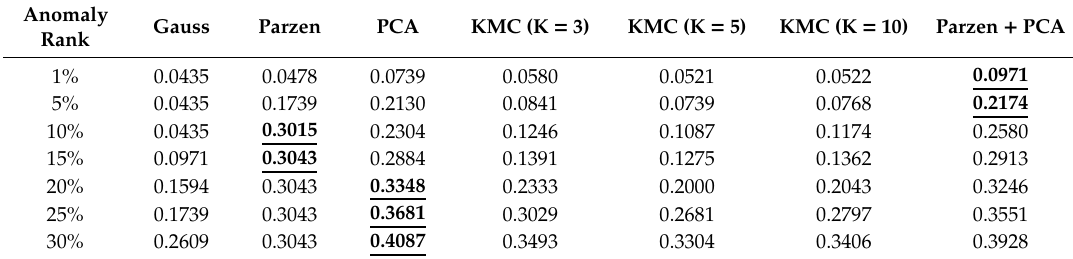
Table 11. True detection rate of each anomaly detection algorithm based on the daily activity summary dataset (IT Admin). Best performance is shown in bold and underlined (number of normal behaviors in the test set: 3424, number of malicious behaviors in the test set: 23).